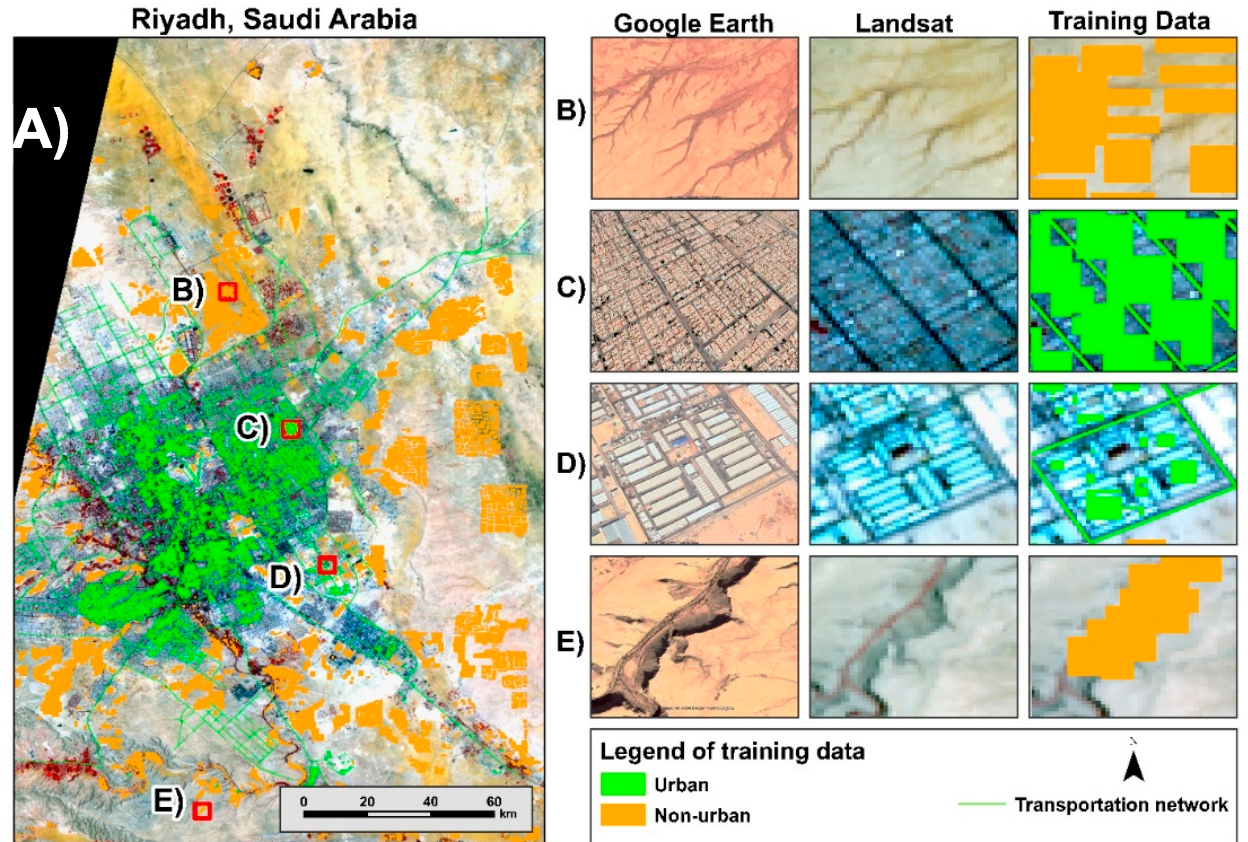
Figure 3. ( A ) Overview of Riyadh, Saudi Arabia. ( B – E ) Urban and non-urban training data at four different sites in Riyadh. Table 1. Collected training data from the 13 capitals.